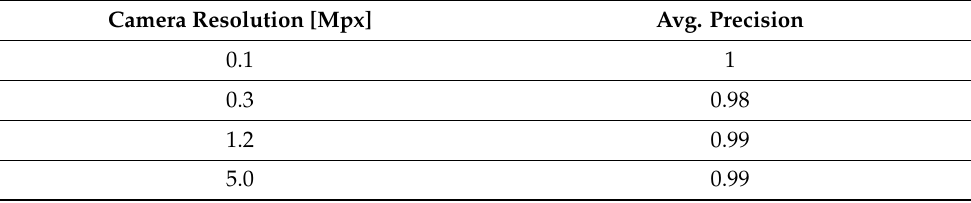
Table 3. Average precision for bee identification depending on camera resolution.